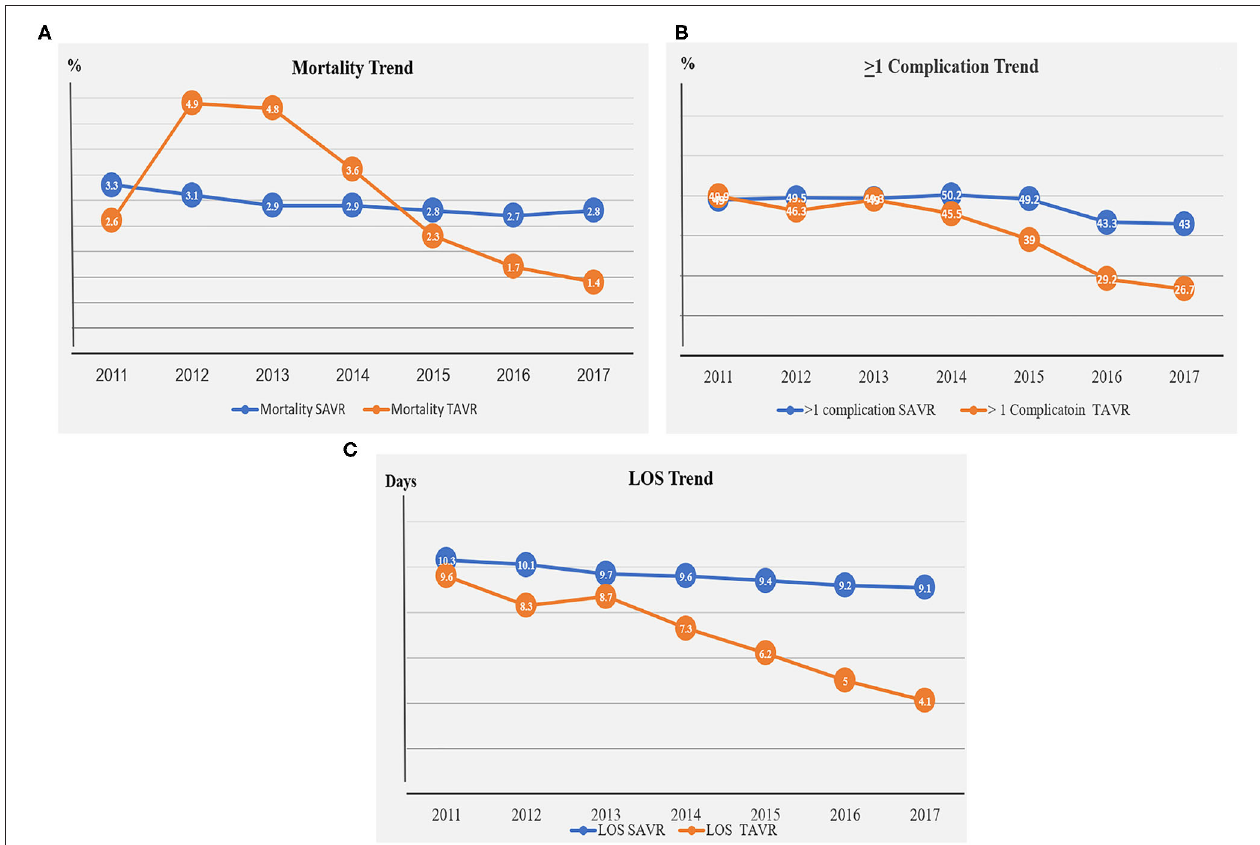
FIGURE 2 | (A) Mortality trend in the SAVR and TAVR groups during the years 2011–2017. (B) Complication trend in the SAVR and TAVR groups during the years 2011–2017. (C) LOS trend in the SAVR and TAVR groups during the years 2011–2017.